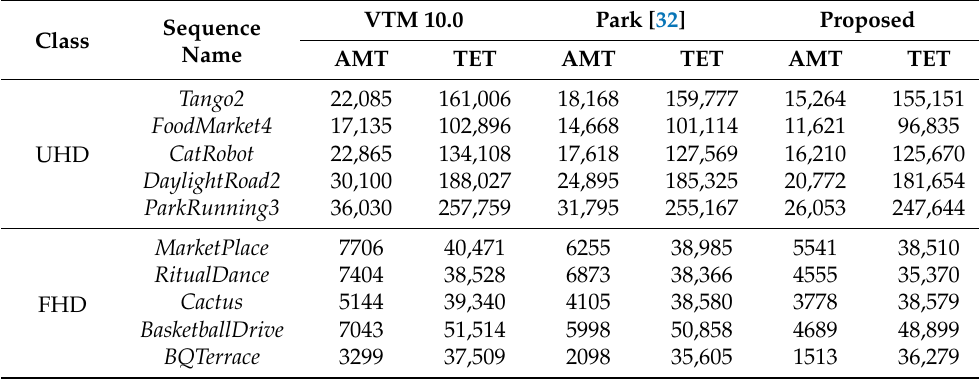
Table 5. Encoding time (second) for anchor, the previous [32], and the proposed method.